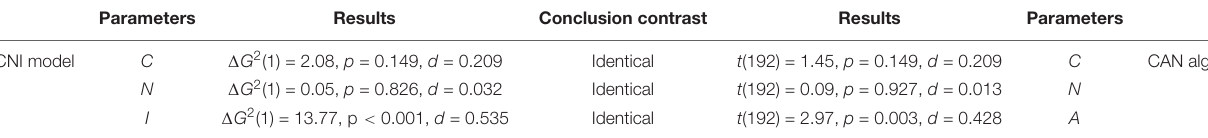
TABLE A2 | Test of differences in cognitive load with the CNI model and CAN algorithm in Study 2b by Gawronski et al. (2017). Parameters Results Conclusion contrast Results Parameters